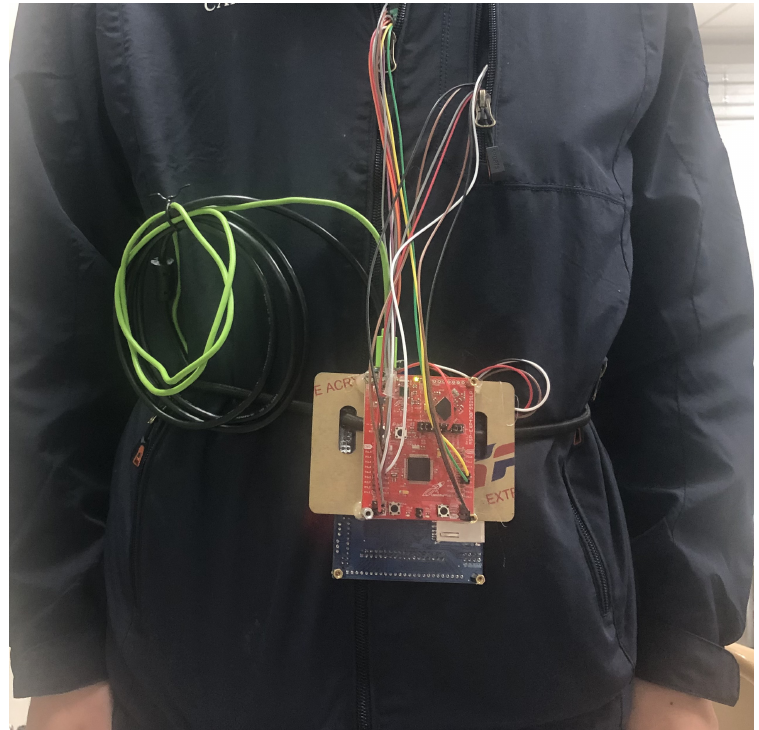
Figure 7. System implementation on one subject’s body.